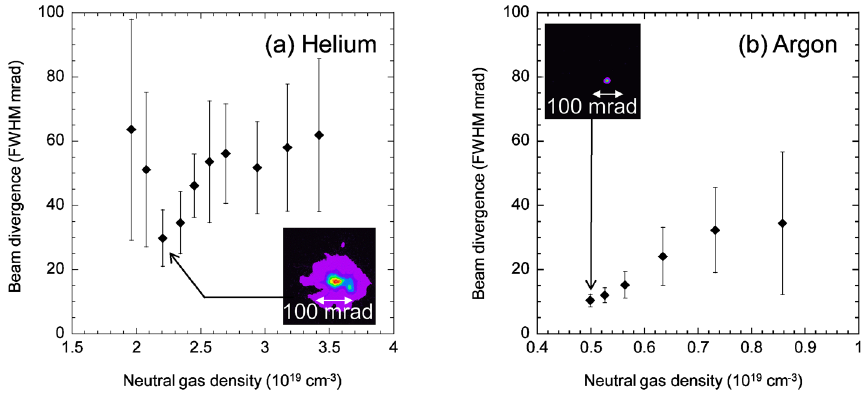
FIG. 2. (Color) Beam divergence of the electron bunch plotted as a function of plasma density for > 1 MeV electrons, (a) in He and (b) in Ar.